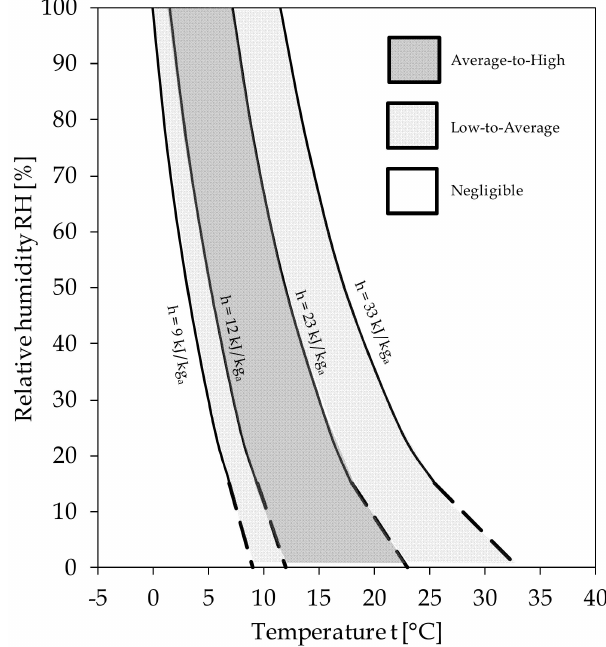
Figure 4. A chart of the suggested levels of seasonal virulence risk (SVR), expressed in terms of relative humidity (RH) and temperature of the atmospheric